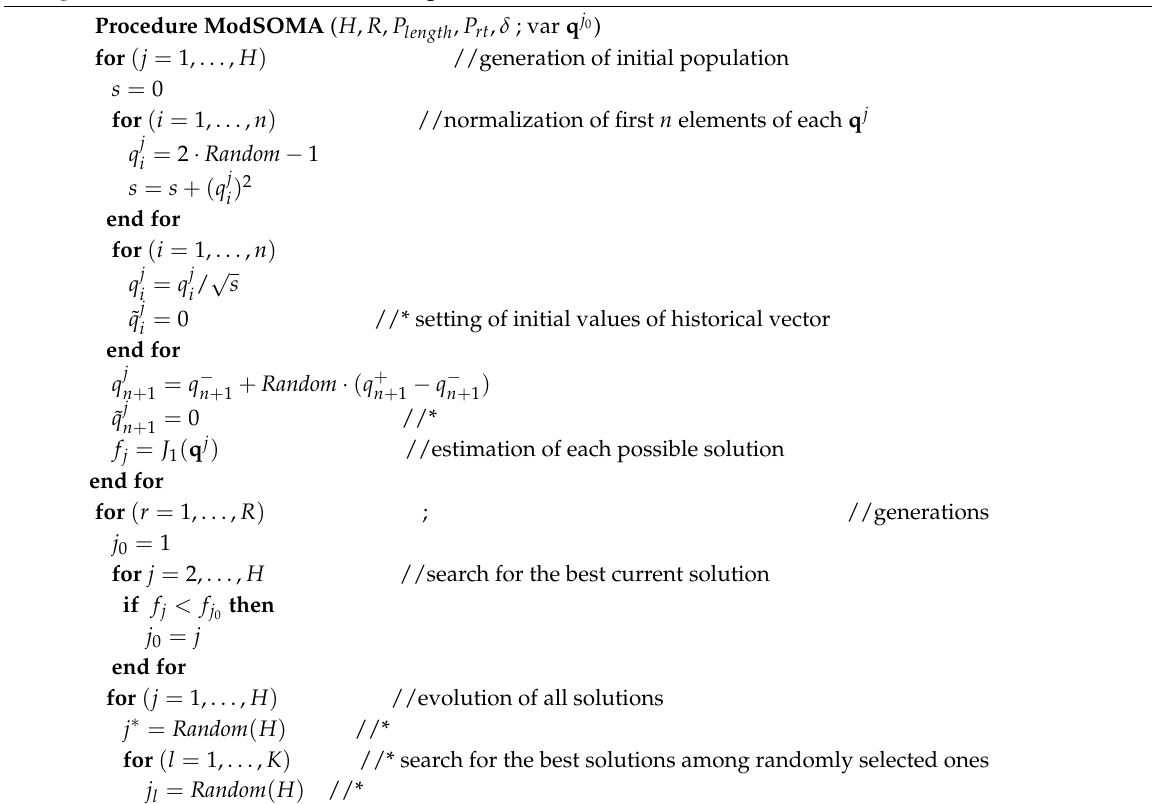
Algorithm 1: Modified SOMA for Optimal Control